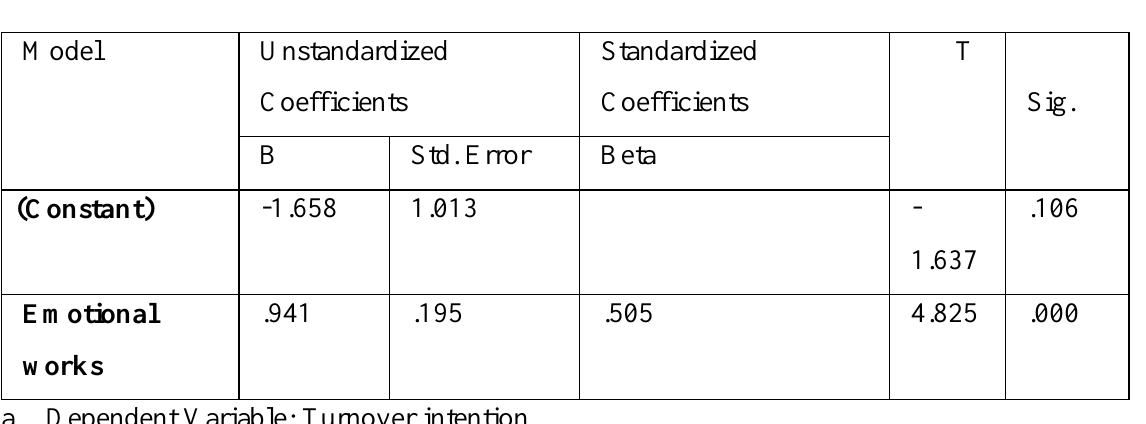
Table 7: Simple Regression Statistics of Independent and Dependent